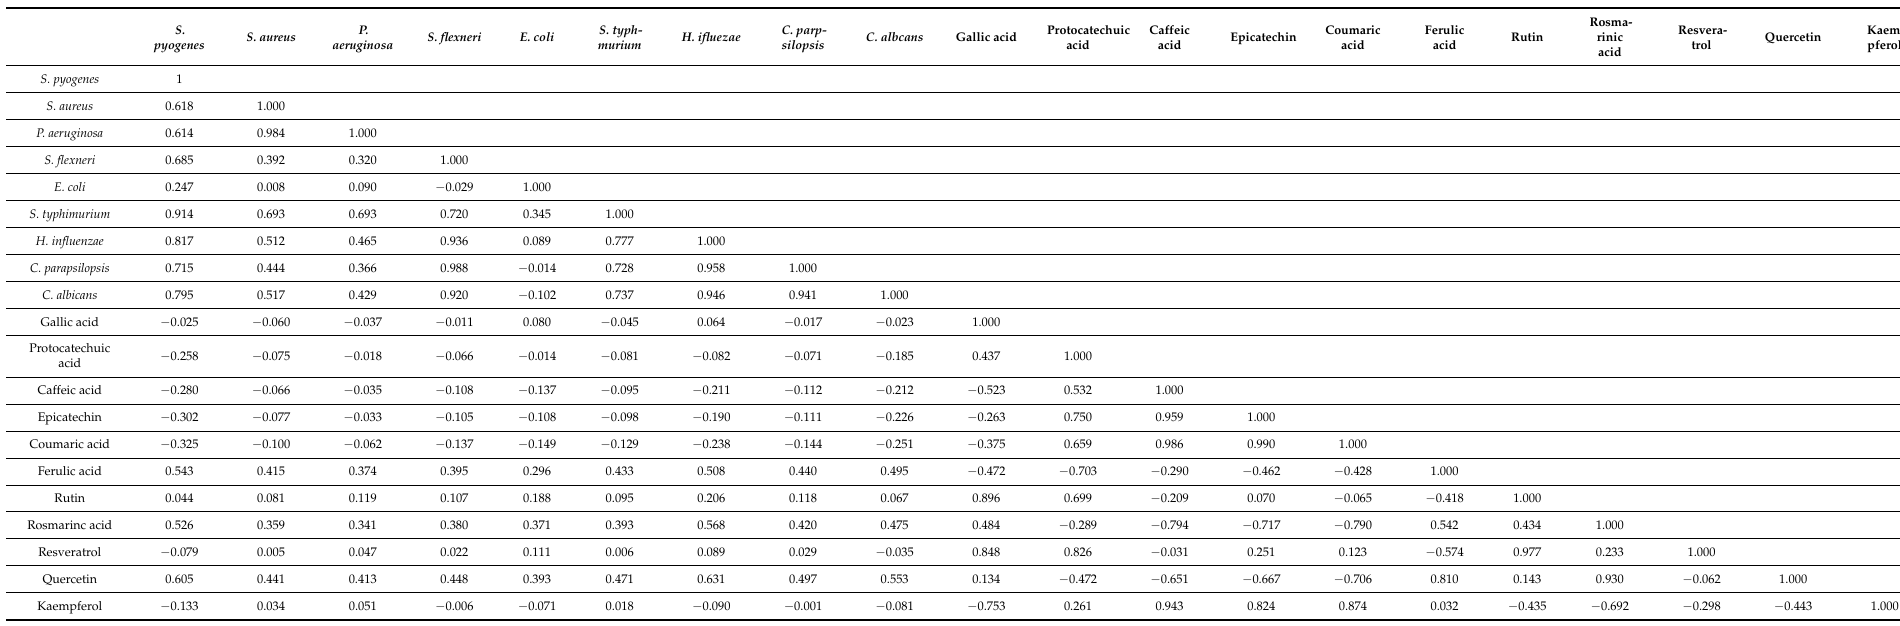
Table 6. Correlations between variables (OD mean values of spectrophotometric determination of antimicrobial activity and the polyphenol concentration analyzed by